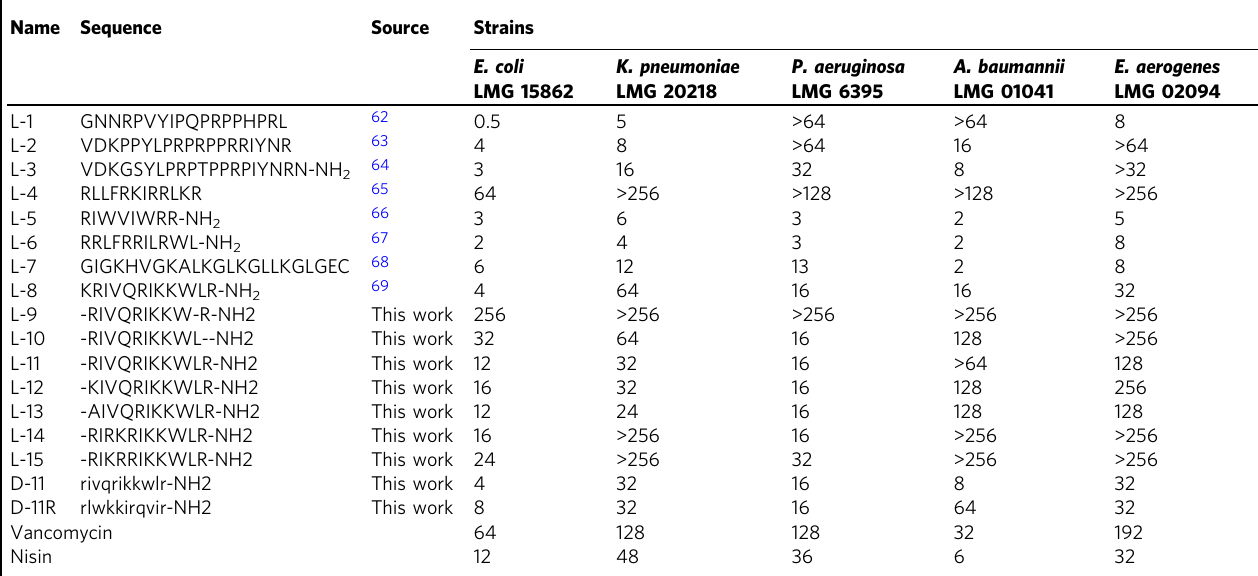
Table 1 Sequences and MIC ( µ M) of the different peptides and antimicrobials used in this work. D amino acids are indicated in